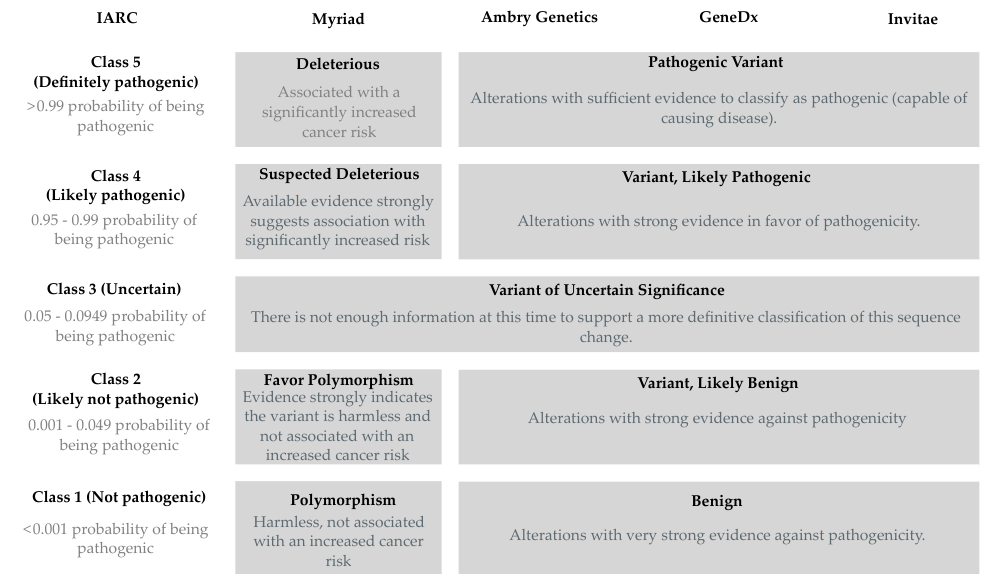
Figure 1. Variations of the five-tier system used to convey information about a variant in BRCA1. Classification recommended by the IARC Unclassified Genetic Variants Working Group (IARC) and endorsed by the Evidence-based Network for the Interpretation of Germline Mutant Alleles (ENIGMA) Consortium, and reported by select commercial testing companies in the U.S.